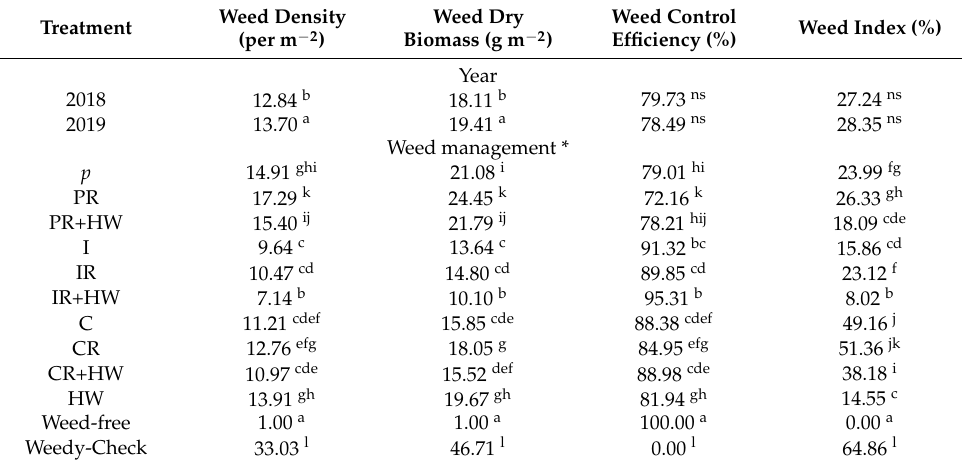
Table 4. The effect of year and weed management treatments on total weed density, total dry weed biomass, weed control efficiency, and weed